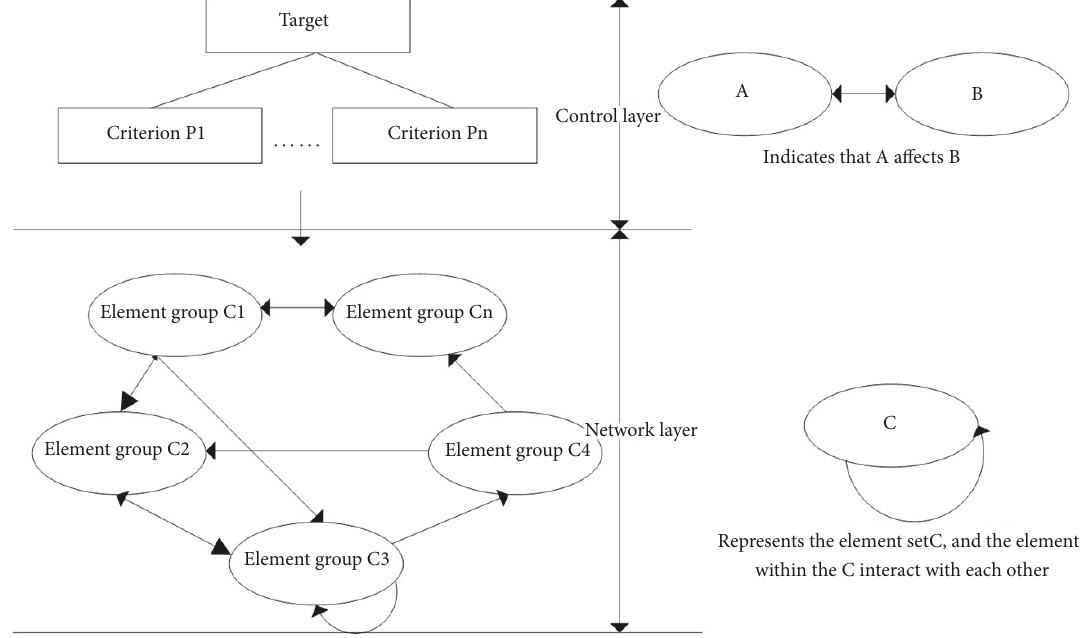
Figure 2: The typical ANP